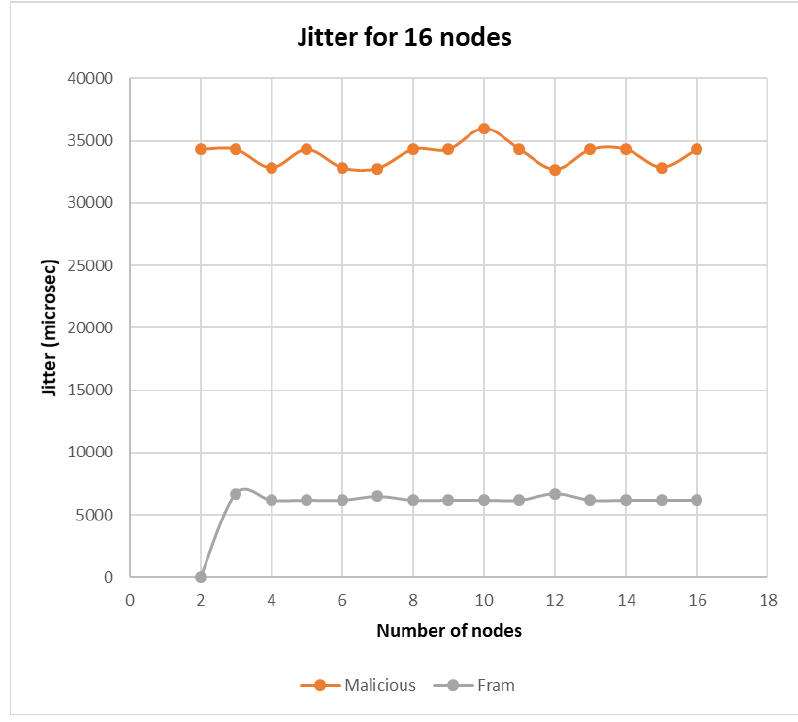
Figure 12. Jitter for 16 nodes.